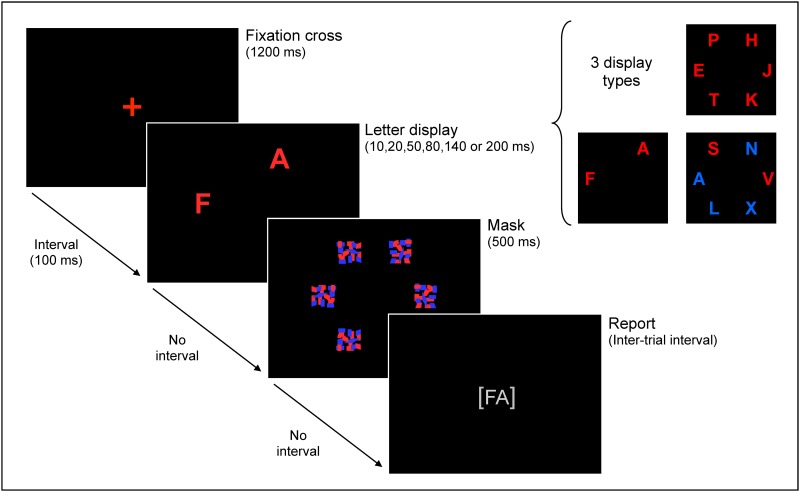
Illustration of the trial outline of the CombiTVA paradigm used to test attentional functions.